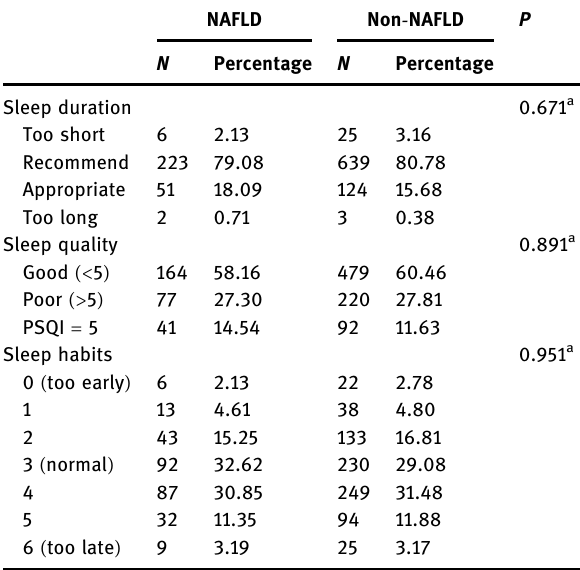
Table 2: Summary data for sleep status and subjects composition